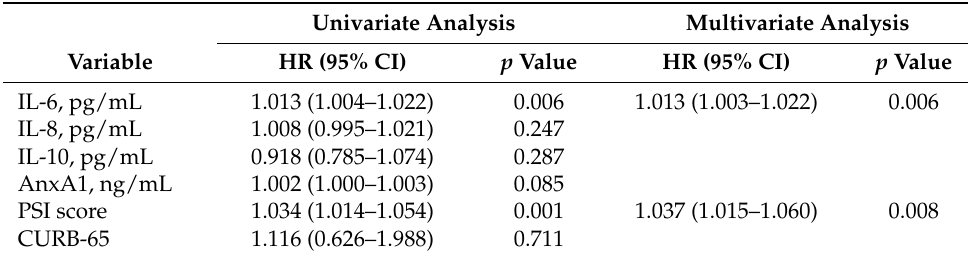
Table 6. Cox proportional hazard regression analysis of the effects of multiple variables on 30-day survival of patients with CAP.